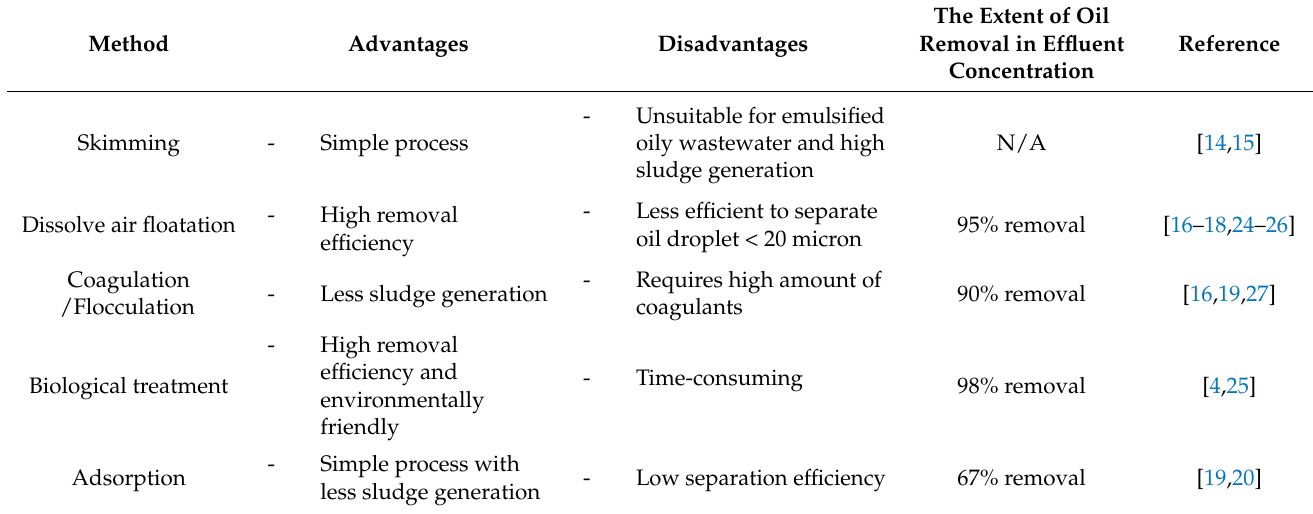
Table 1. Summary of common technology for the treatment of oily wastewater with their main advan- tages and